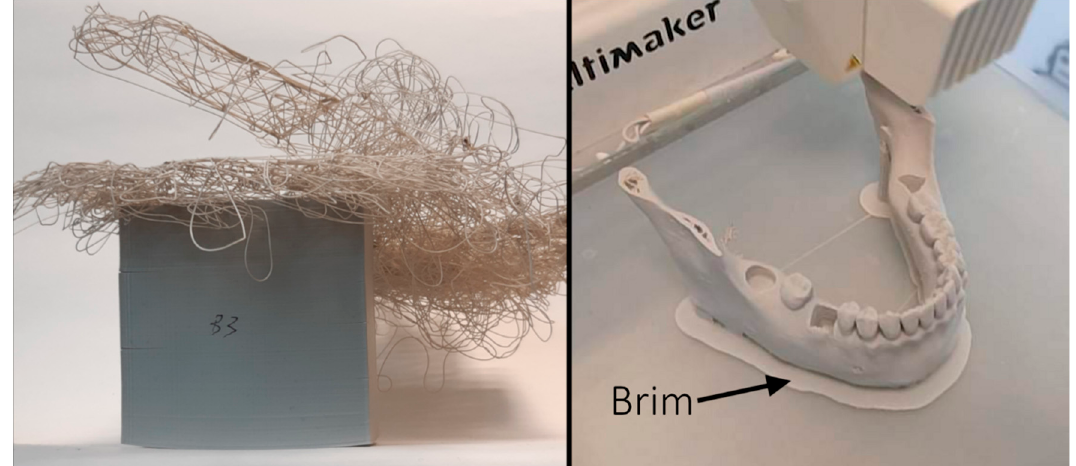
Figure 17. ( Left ): Photo of a sample that broke off the substrate during printing. As a result of warping, the adhesion surface of the sample decreased, which, due to the large moment of force generated by the printing head (high sample-large force arm), resulted in the sample detaching from the bed. This is an example of the negative effects of warping. ( Right ): example of brim, which could reduce warping. Own work.